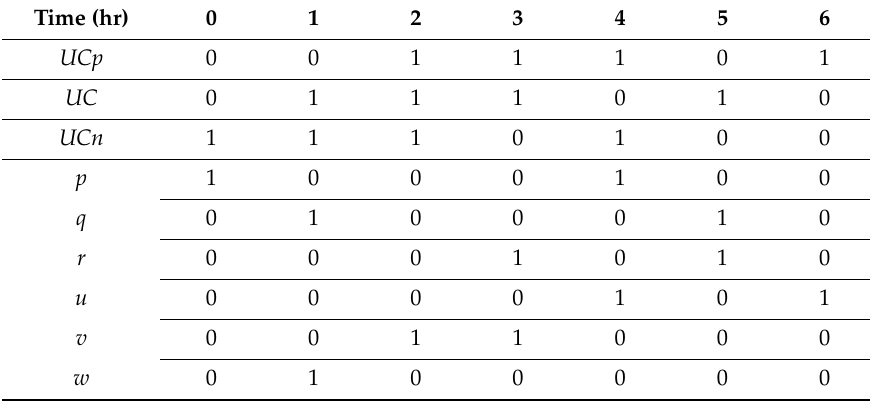
Table 1. Repair strategy